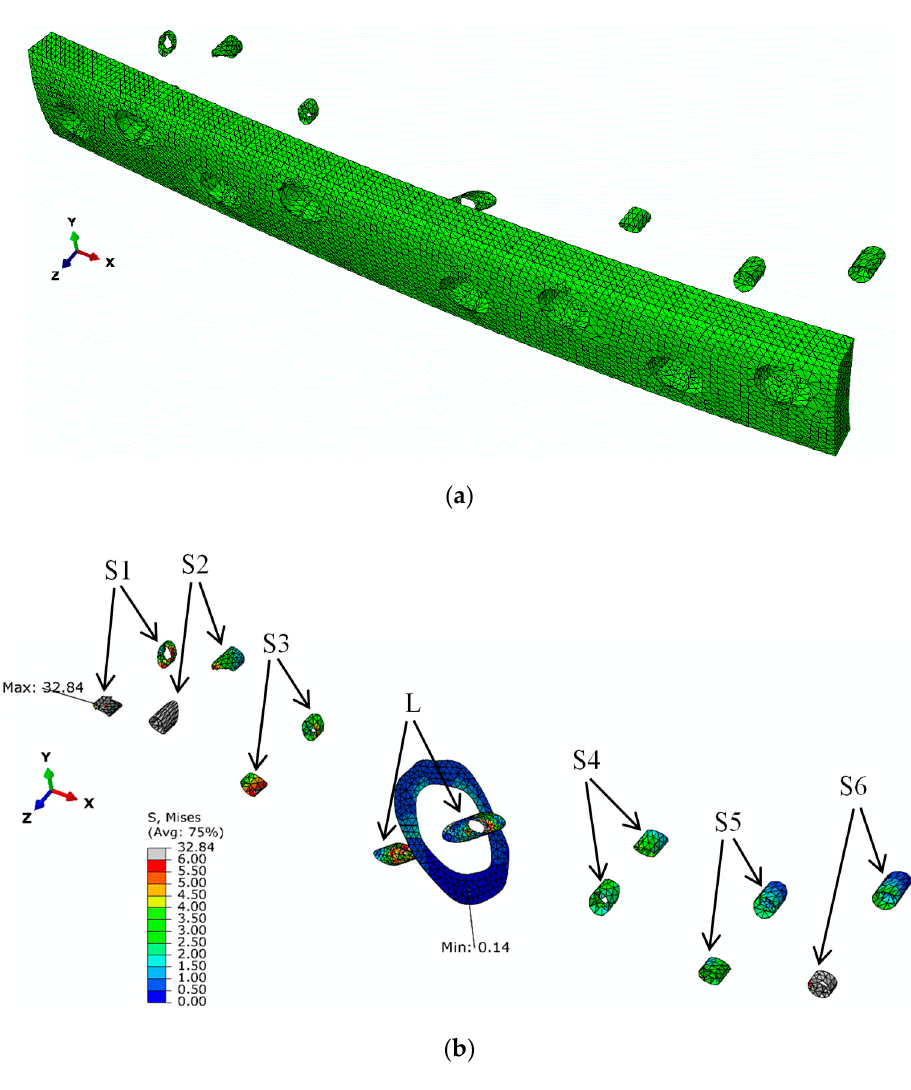
( b ) Figure 17. Shear stress in bone regions S1–S6 (and Lag) sited ( a ) in contact with the metal plate and ( b ) on the opposite side of the bone shaft. The von Mises stresses were also analyzed in the oblique fracture section (Figure 18). It can be observed that the stress field at the inferior part of the oblique section is almost null, due to the separation of bone sections in the course of the bending loading. Since bone healing requires the existence of compressive stresses along the fracture section, it can be concluded that this is a critical region regarding the restorative process. This stress distribution is governed by the applied load, which can be estimated with the developed numerical model. Bone fracture repairing techniques can benefit a lot from the employment of numer ‐ ical models that allow simulating damage initiation and propagation in bone tissue. This strategy originates the accurate evaluation of bone stress (including the fracture surfaces), rendering it possible to analyze the effect of bone repair therapies. Once applied to human bone tissue, the developed procedures may contribute to help surgeons to support deci ‐ sions regarding bone repair using standard DCP and, posteriorly, locking plates.